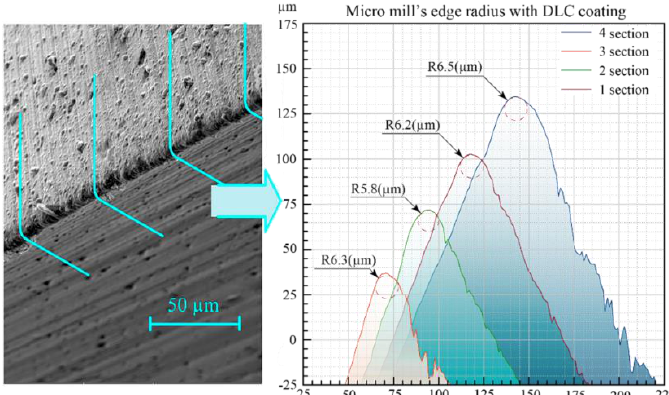
Figure 11. Profilogram of the end mill surface without the detached mask ( a ) and construction of a two-layer DLC coating deposited on a 3-mm-diameter end mill ( b ).